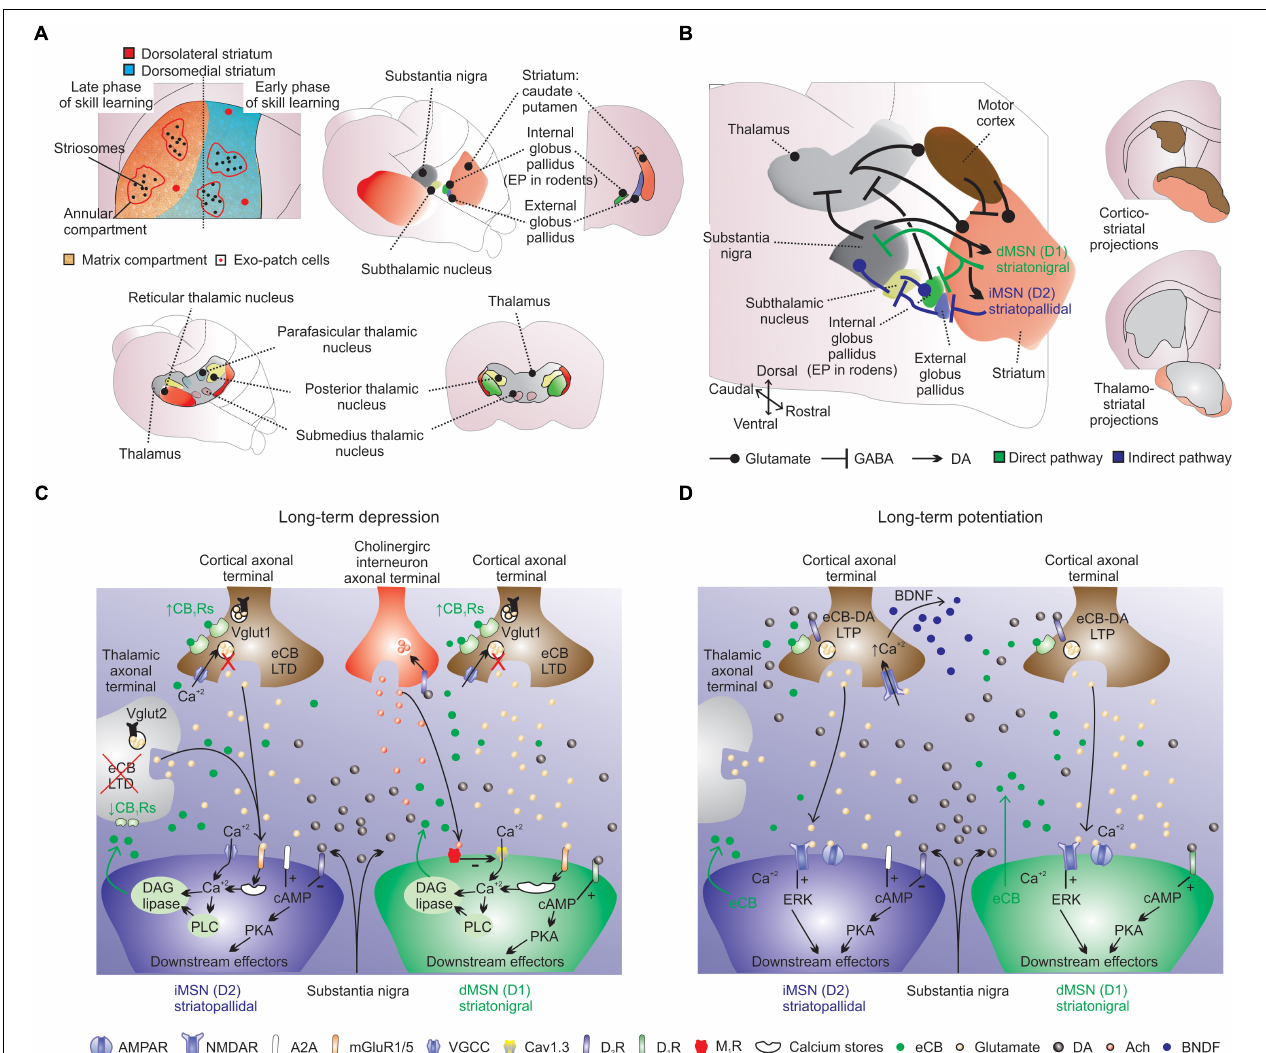
FIGURE 3 | Striatal cellular and synaptic organization. (A) Striatum is a single structure in rodents: see striatal theoretical compartmentalization into dorsolateral (red; putamen) and medial (blue; caudate) striatum (Hjornevik, 2007; Heilbronner et al., 2016). Early and late skill learning are suggested to occur in a mediolateral fashion, respectively. ( A , lower panels) In rodents the main thalamo-striatal afferents originate from the parafascicular nucleus. (B) The striatal circuit is composed of several intertwined structures involved in inhibition (indirect-pathway) or disinhibition (direct-pathway) of movement. The indirect-pathway (blue arrows) is formed by striatopallidal MSNs (iMSNs) that project to GABAergic pallidal neurons (external globus pallidus), which exert a powerful inhibitory control into proximal dendrites of glutamatergic neurons in the subthalamic nucleus. Subthalamic nucleus neurons send excitatory afferents to inhibitory output neurons of substantia nigra, and also to internal globus pallidus neurons. The net effect of indirect-pathway activation is inhibition of thalamo-cortical projection neurons, which can reduce cortical premotor drive and inhibit movement. The direct-pathway circuit (green arrows) is formed by striatonigral medium spiny neurons (dMSNs) that provides mainly inhibitory inputs to both GABAergic and dopaminergic cells in substantia nigra, which in turn sends axons to motor nuclei of the thalamus. Direct-pathway activation results in disinhibition of excitatory thalamo-cortical projections, resulting in activation of cortical premotor circuits and the selection/facilitation of movement. Glutamatergic striatal inputs from all cortical areas massively converge into the striatum. Also note the long-range GABAergic projections from the motor cortex to the dorsal striatum. Cortico-striatal and thalamo-striatal glutamatergic inputs target MSNs, large cholinergic interneurons and fast spiking interneurons. Cortico-striatal projections receive several inputs and integrate this information into striatal target neurons. Cholinergic interneurons receive scattered excitatory innervation mainly from thalamus and inhibitory synapses from MSNs. ‘Up-states’ are modulated by intrastriatal acetylcholine (ACh) and to strong intra-striatal DA release, D 1 Rs activation and striatal LTP. Midbrain dopaminergic terminals release dopamine (DA), which exerts a massive effect on all striatal cells. “Down-states” are associated to reduced intra-striatal DA, D 1 Rs/D 2 Rs activation and striatal LTD. Striatal LTP/LTD is also dependent on NMDARs activation and Ca 2 + influx in MSNs. ( B , right panels) Also note the distribution of cortico-striatal and thalamo-striatal afferents (Hunnicutt et al., 2016). (C) Long-term depression is dependent on mGLU 1 / 5 Rs, D 2 Rs, M 1 Rs, and C 1 BRs. For example, in iMSNs, prolonged stimulation of excitatory afferents paired with post-synaptic depolarization triggers the production and release of eCBs (e.g., 2AG) from the precursor diacylglycerol (DAG) through the activation of mGlu 1 / 5 Rs and phospholipase C (PLC; this process is dependent on Ca 2 + ). (D) Long-term potentiation is dependent on NMDARs, D 1 Rs, A2ARs and CB 1 Rs. LTP is NMDARs dependent and is likely to involve the exocytosis of AMPA receptors. For example, LTP in the indirect pathway is negatively regulated by D 2 Rs (dependent on extracellular regulated kinase; ERK) and positively regulated by adenosine